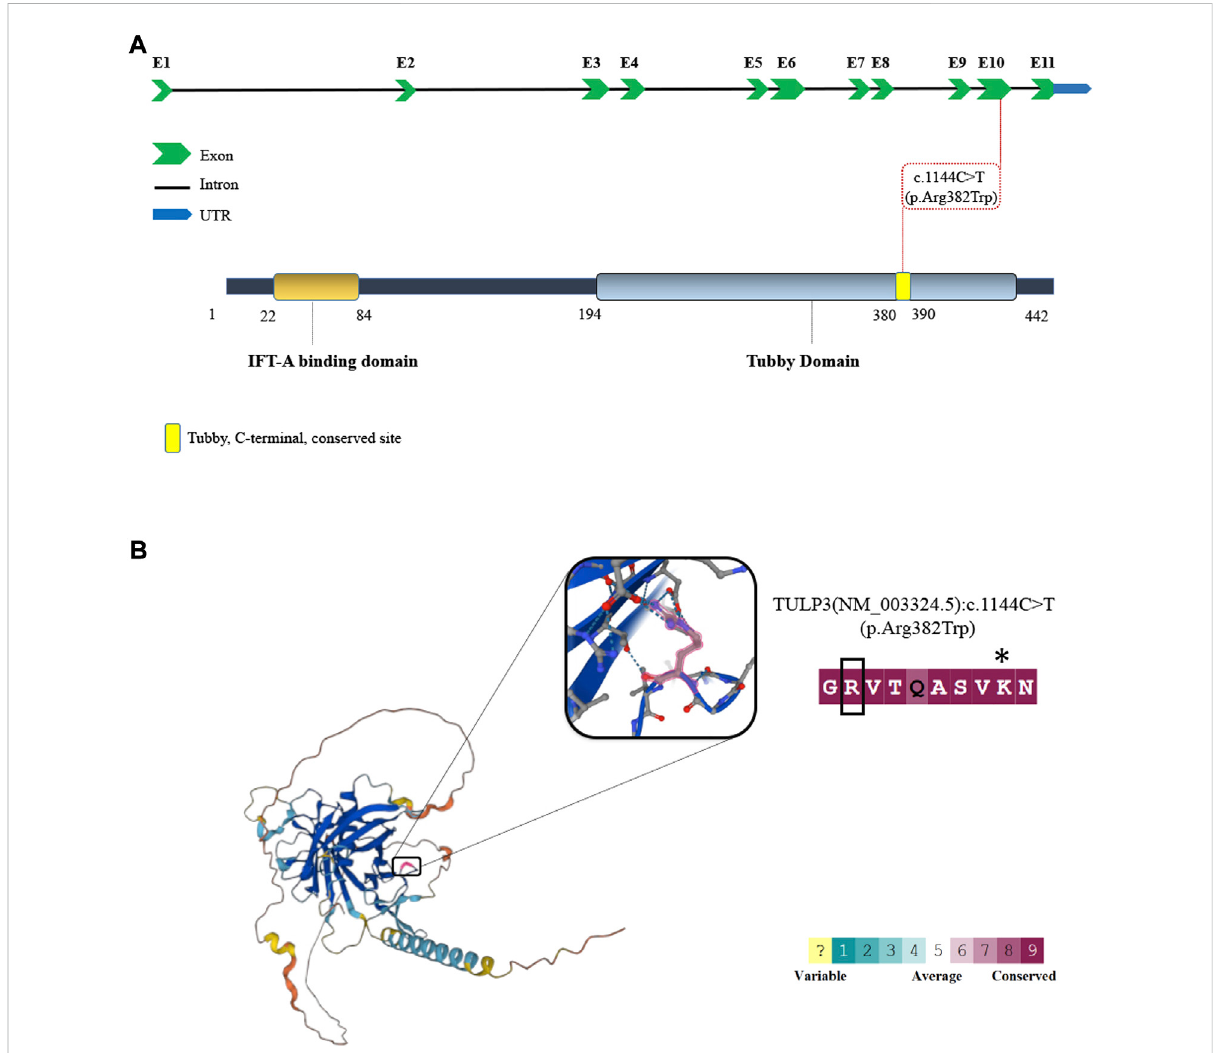
The schematic depiction of TULP3 mutation. (A) Schematic depiction of the human TULP3 locus with 11 exons (top) and Tubby-like protein 3 (bottom). The red dash line represents the variant in the present study. (B) Three-dimensional structure of TULP3 protein and illustration of the conservationscores.Thepositionofthepathogenicvariantinthisstudy(pink)areshownontheProteinStructureandillustrationoftheconservation scores (consurf). * represents the site of lysine to isoleucine missense mutation in the mouse Tulp3 associated with cystic kidneys (Legue and Liem,